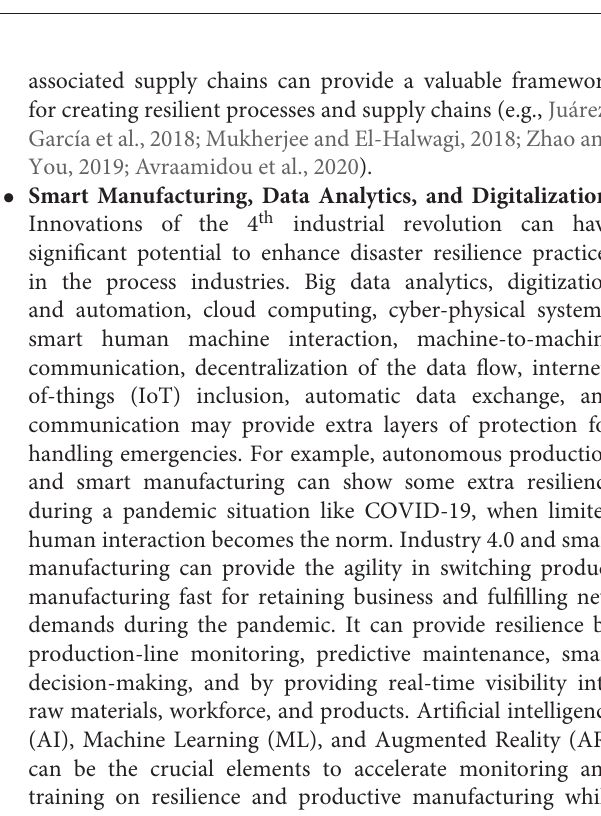
FIGURE 9 | Lifecycle stages of resilience following a disruptive